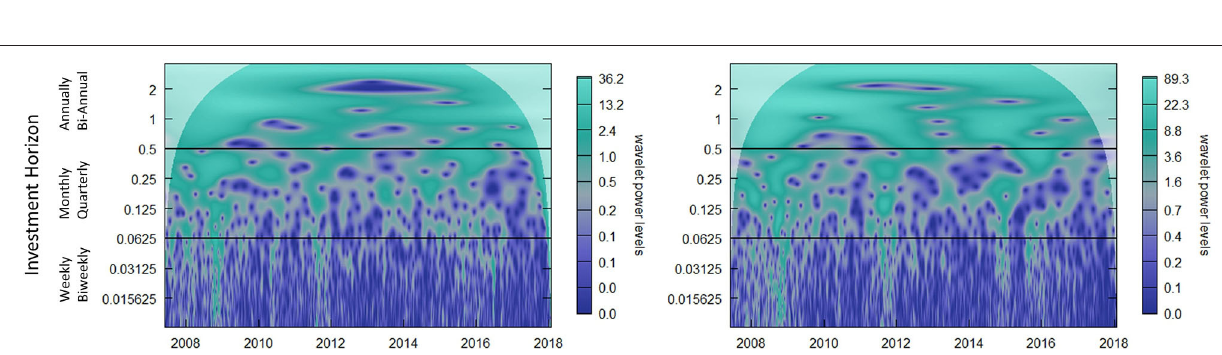
FIGURE 5 | The continuous wavelet transform (CWT) power spectrum of water (CGW left) and energy (XLE right) commodity ETF prices. These two plots are visual representations of the power spectrum of each individual series. The investment horizons (vertical axis) are such that the value one represents 250 days (annual investment horizon) and 0.25 represents 64 days (quarterly investment horizon). The horizontal axis indicates the 10 years of data. These plots are divided into three sections with the goal of separating low (bottom), medium (middle), and high (top) power. These sections are categorized as regions which are representative of short (weekly, biweekly), medium (monthly, quarterly), and long (annually, bi-annual) run behavior, respectively. The white overlay defines the cone of influence. Figures were created by implementing minor modifications to Rösch and Schmidbauer (2014).